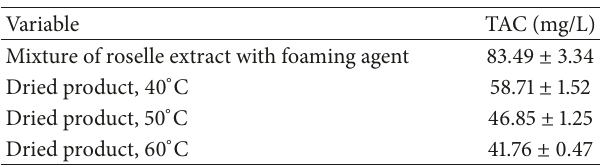
Table 6: The total Anthocyanin content (TAC) of roselle extract drying with